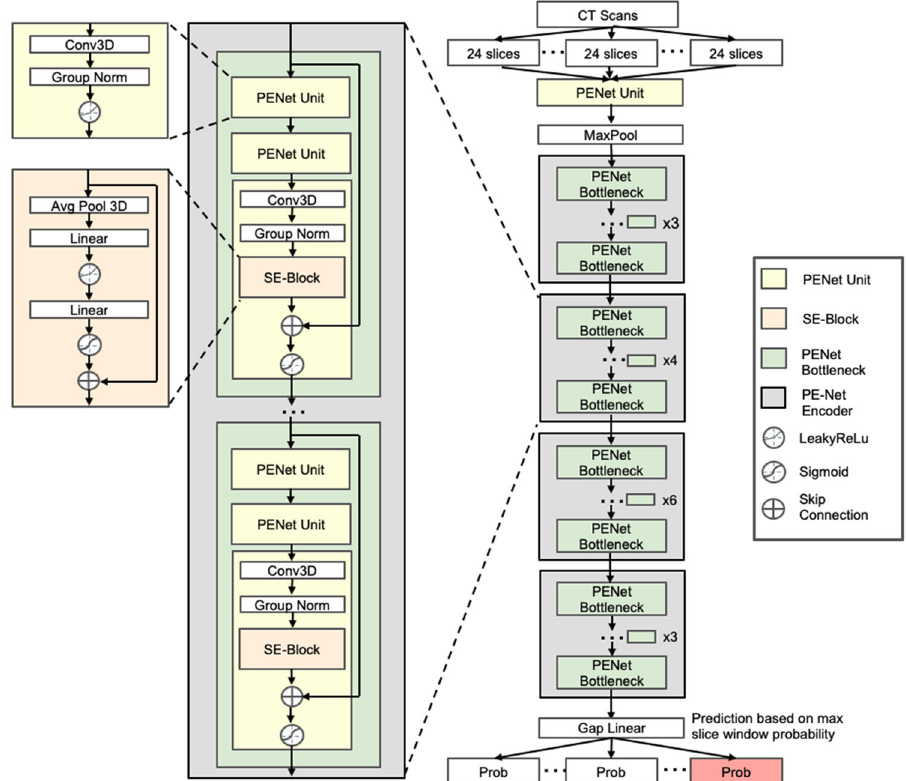
Fig. 4 PENet architecture used in this study. PENet is built using four architectural units: the PENet unit, Squeeze-and-Excitation block, the PE-Net bottleneck, and the PE-Net encoder. Each building block in the network is color-coded.